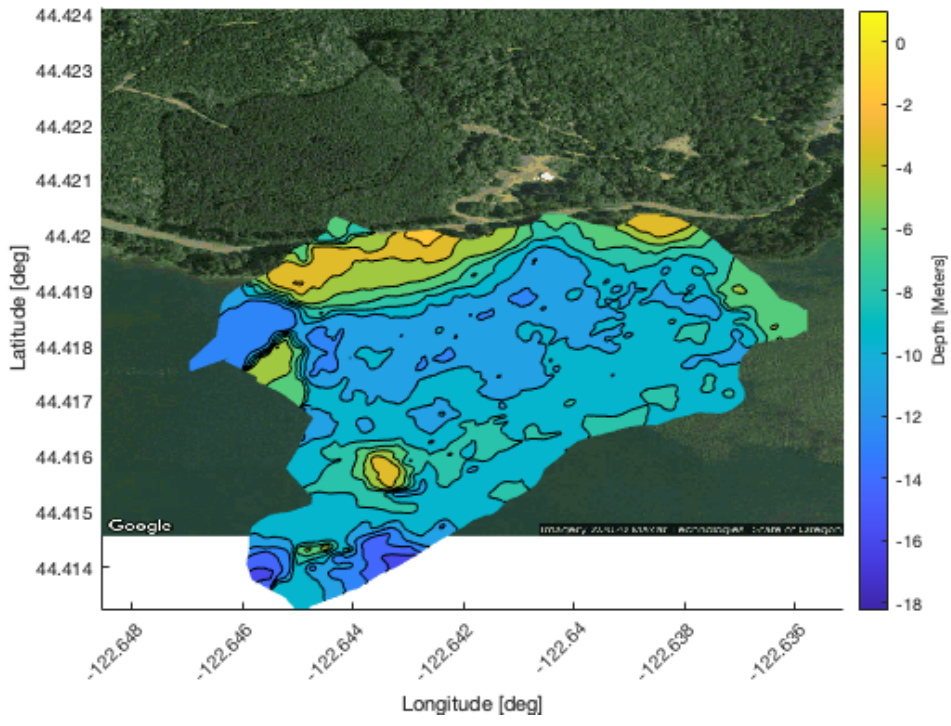
Figure 11. Bathymetry map of Foster Reservoir used for communication planning in decentralized terrain-based navigation field trials. This map a generated from data collected by the